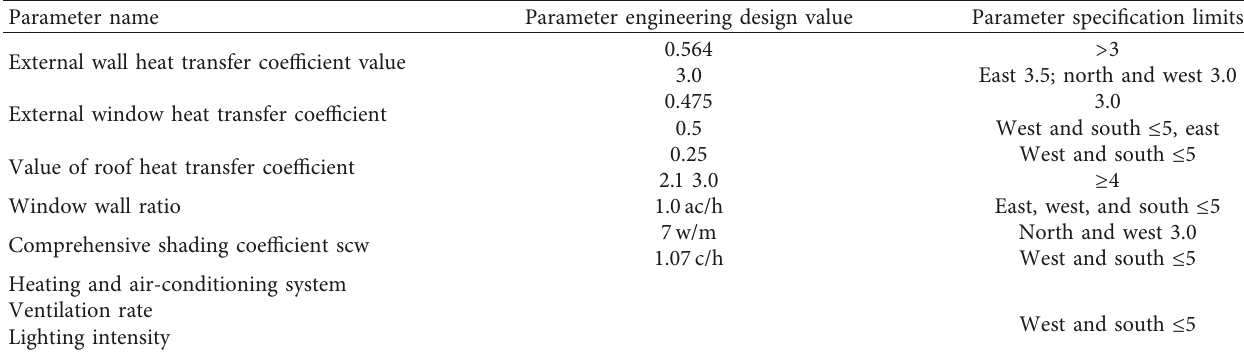
Table 4: Parameter design of reference buildings.